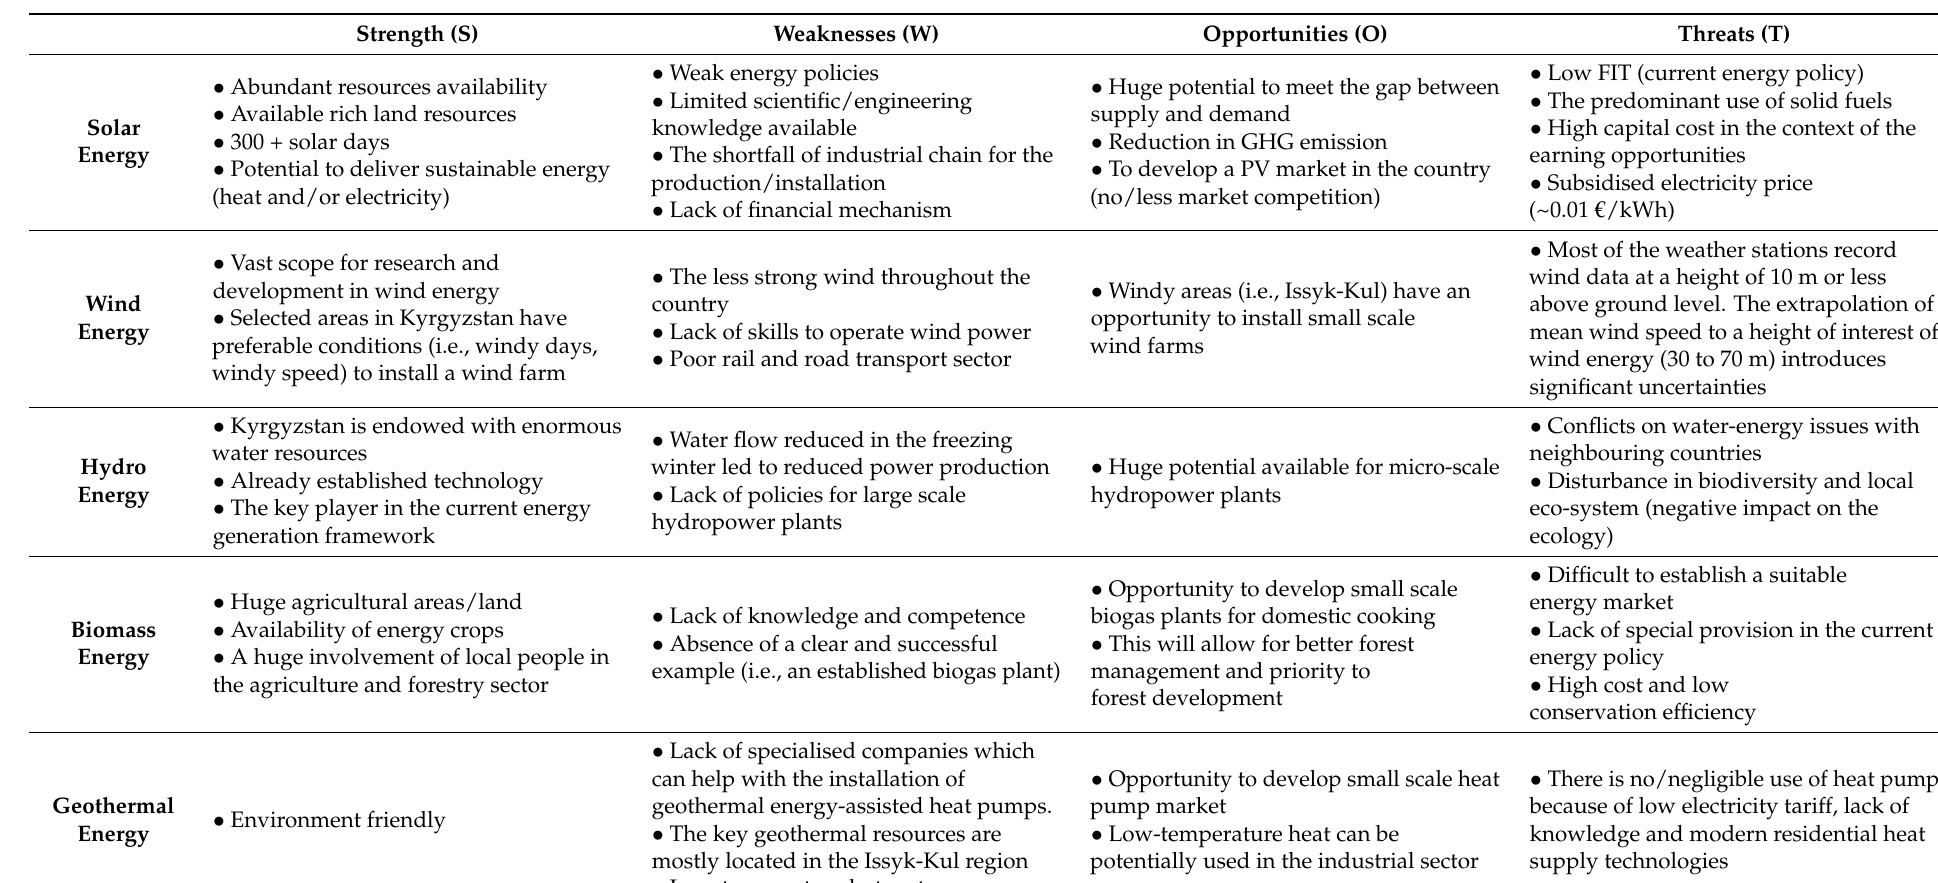
Table 2. SWOT Analysis of Renewable Energy in